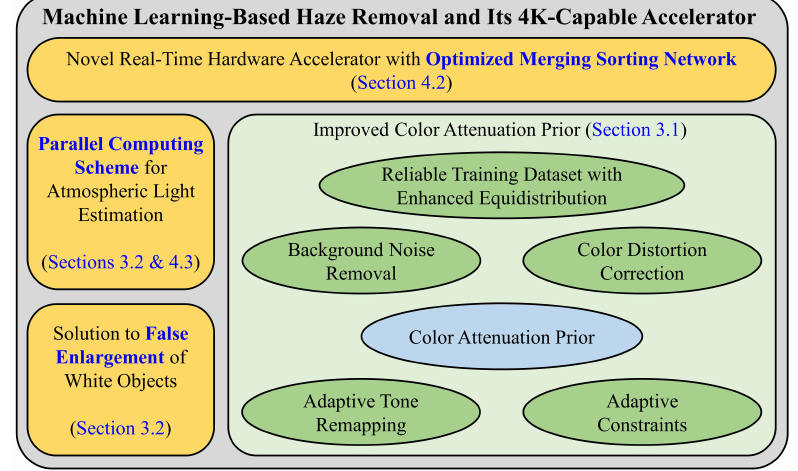
Figure 2. The proposed algorithm with its main contributions to the previous